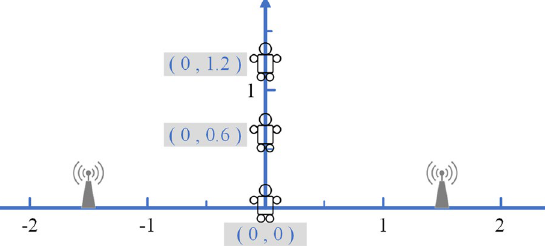
Fig. 8 Position of the transceiver and the human